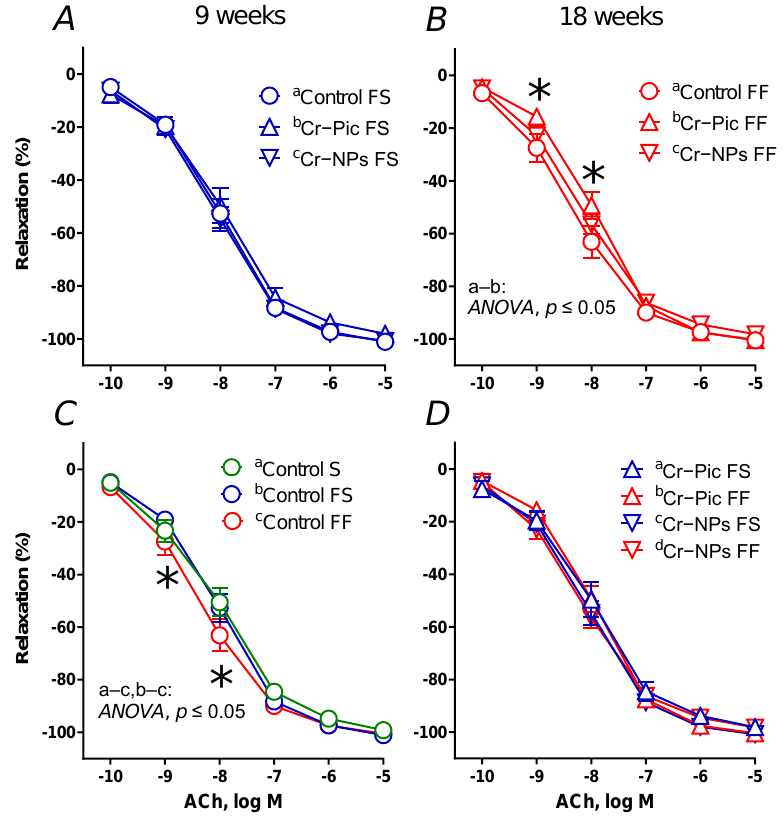
Figure 4. The vasodilator response to acetylcholine (ACh) in aortic rings from either chromium (Cr) supplemented (9 weeks of supplementation) or non-supplemented (Control S, Control FS, and Control FF) rats. 0.3 mg Cr/kg of body weight as chromium picolinate (Cr–Pic) or chromium nanoparti- cles (Cr – NPs) were added after the initial 9 weeks of experimental feed without Cr supplementation.